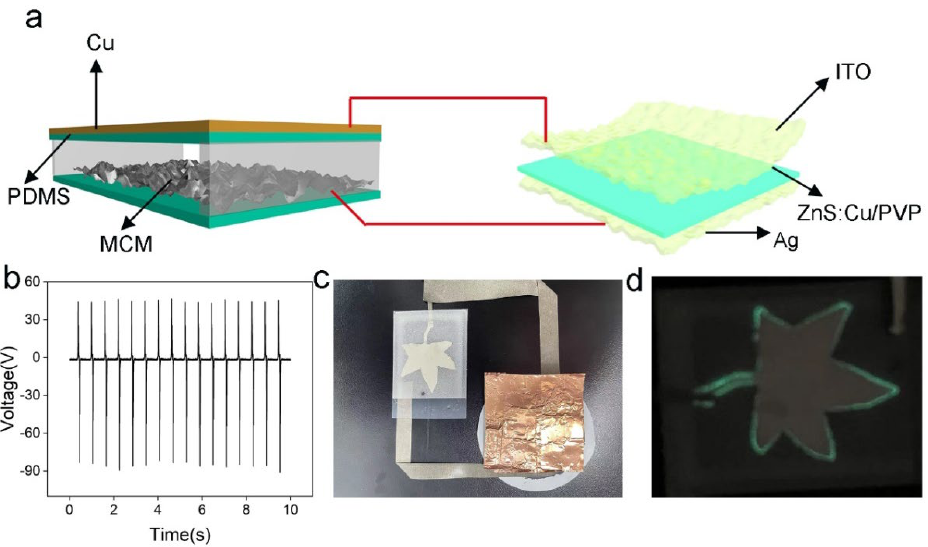
Figure 6. A self-powered display system driven by the MCM-TENG. ( a ) A schematic illustration of the self-powered display system. ( b ) The output voltage of MCM-TENG. ( c ) The photograph of a self-powered display system. ( d ) The display pattern driven by